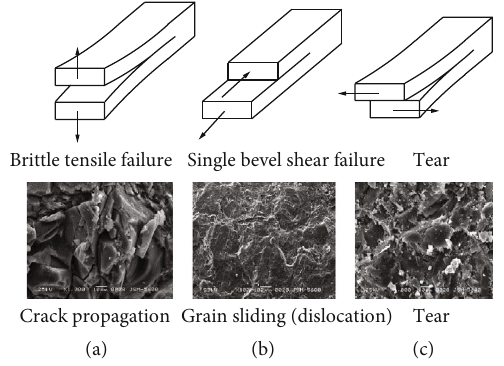
Figure 8: Microscopic failure modes of rock